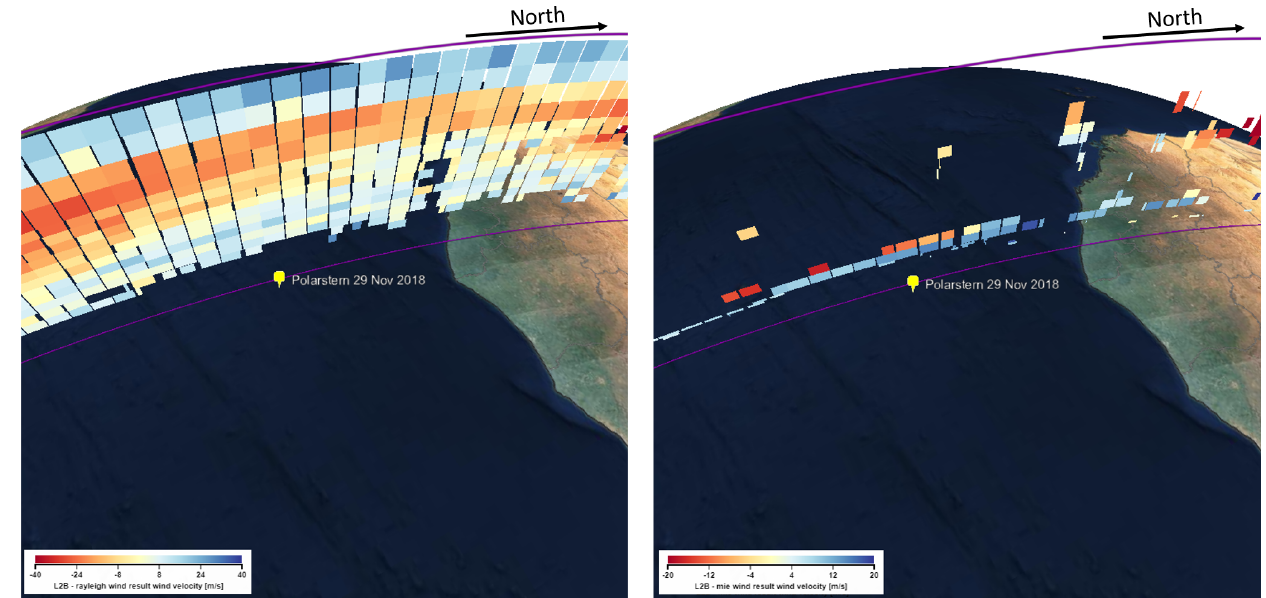
Figure 5. Aeolus HLOS winds on 29 November 2018. Rayleigh clear (left) and Mie cloudy (right) HLOS winds are shown for the overpass around 06:34UTC. The location of RV Polarstern 800km off the shore of Liberia is indicated by the yellow pin. The figure was created with the Aeolus visualization tool VirES (https://aeolus.services/).